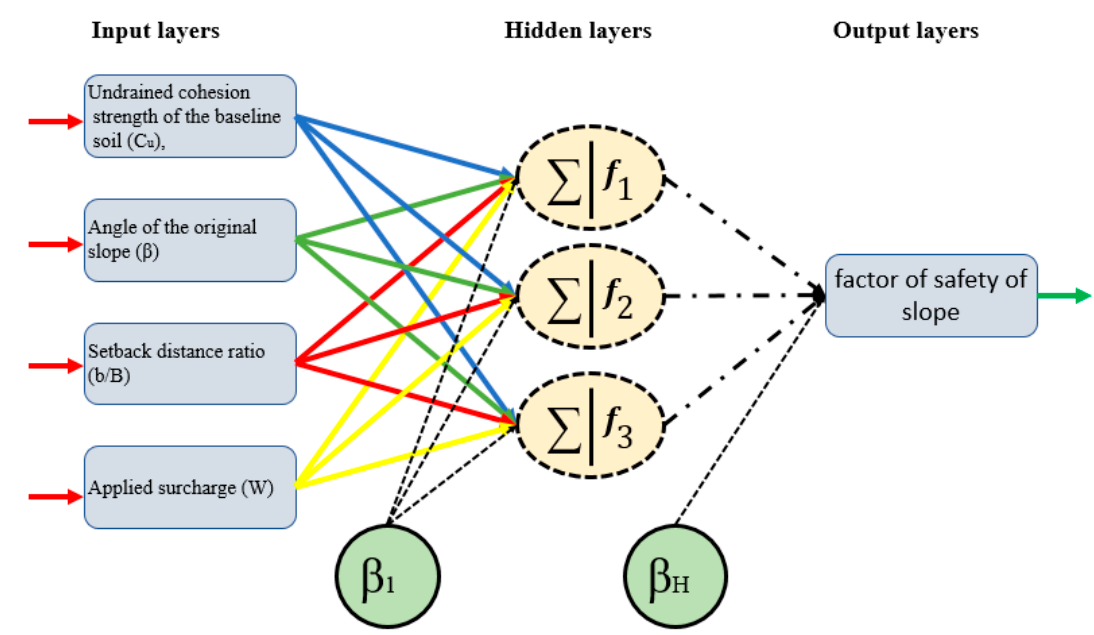
Figure 3. An example of the proposed 4 (input) × 3 (nodes in the first hidden layer) × 1 (output) neural network structure.